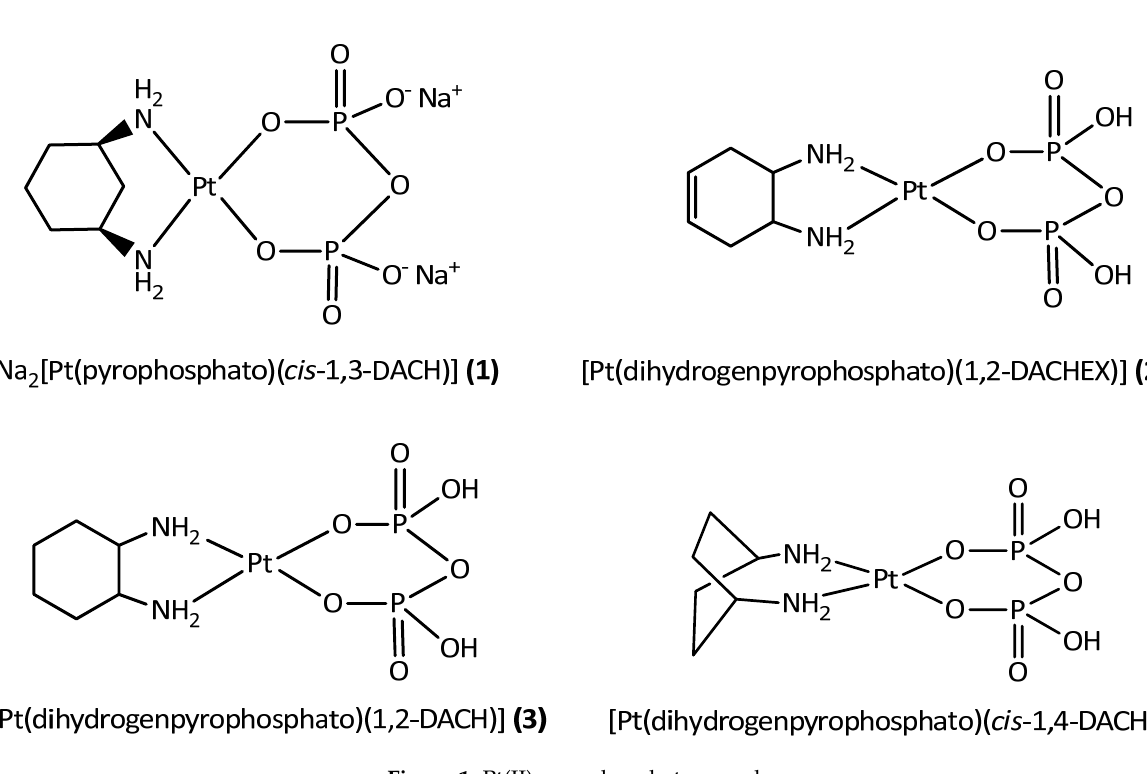
Figure 1. Pt(II)-pyrophosphato complexes.